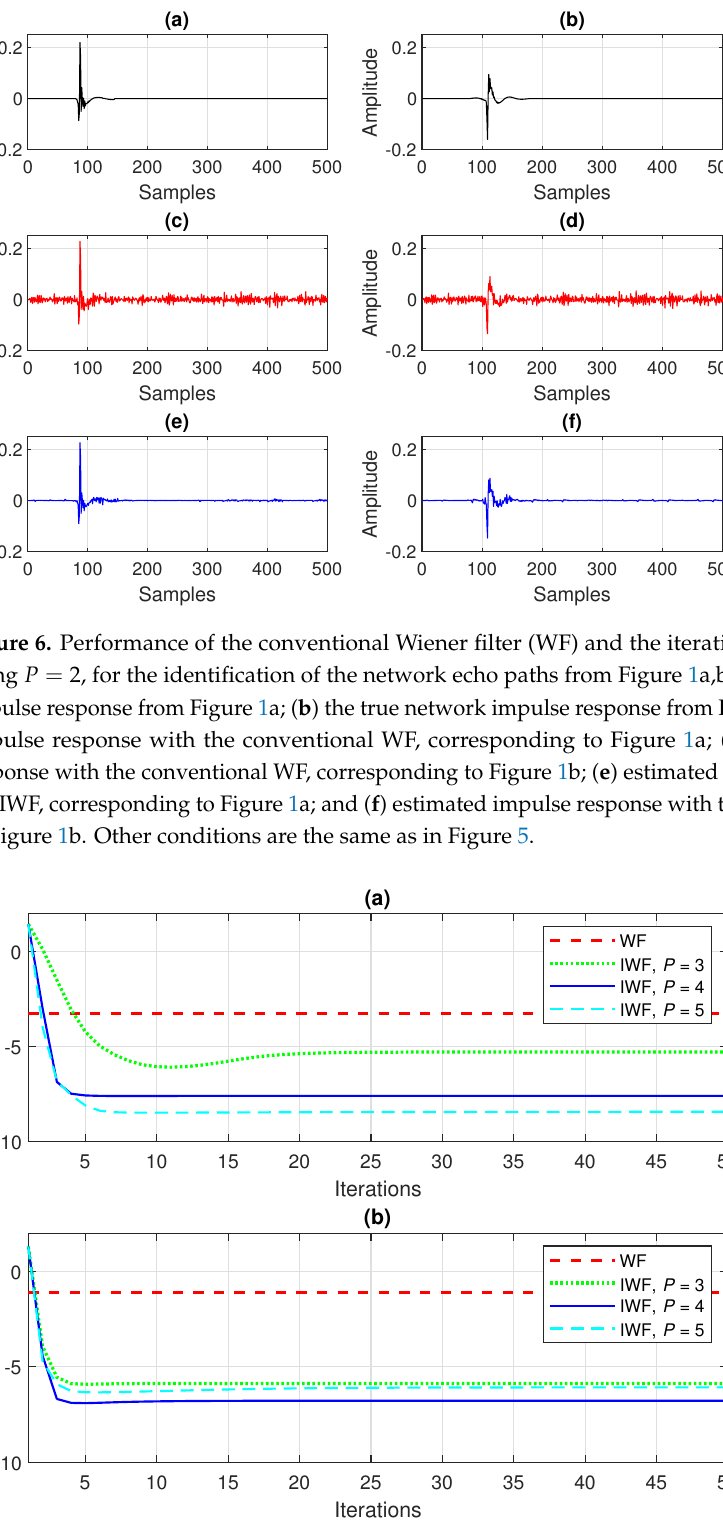
Figure 7. Performance of the conventional Wiener filter (WF) and the iterative Wiener filter (IWF) for the identification of ( a ) the acoustic echo path from Figure 1c and ( b ) the acoustic echo path from Figure 1d. The input signal is an AR(1) process, N = 1000 (available data samples), and SNR = 10